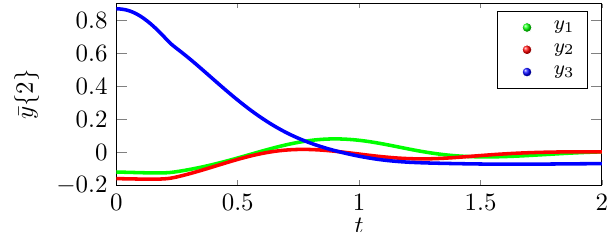
Figure 3. Tracking error with state feedback ¯ u ( 2 ) .